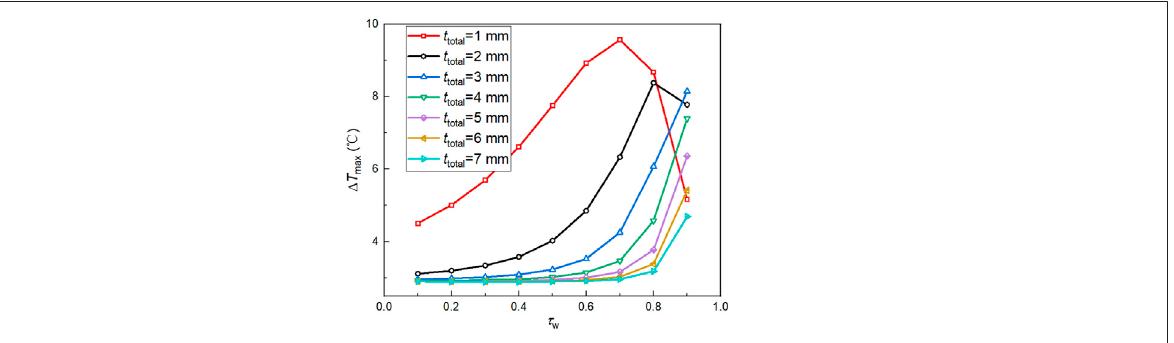
FIGURE 8 | In fl uence of τ w on battery maximum temperature difference.